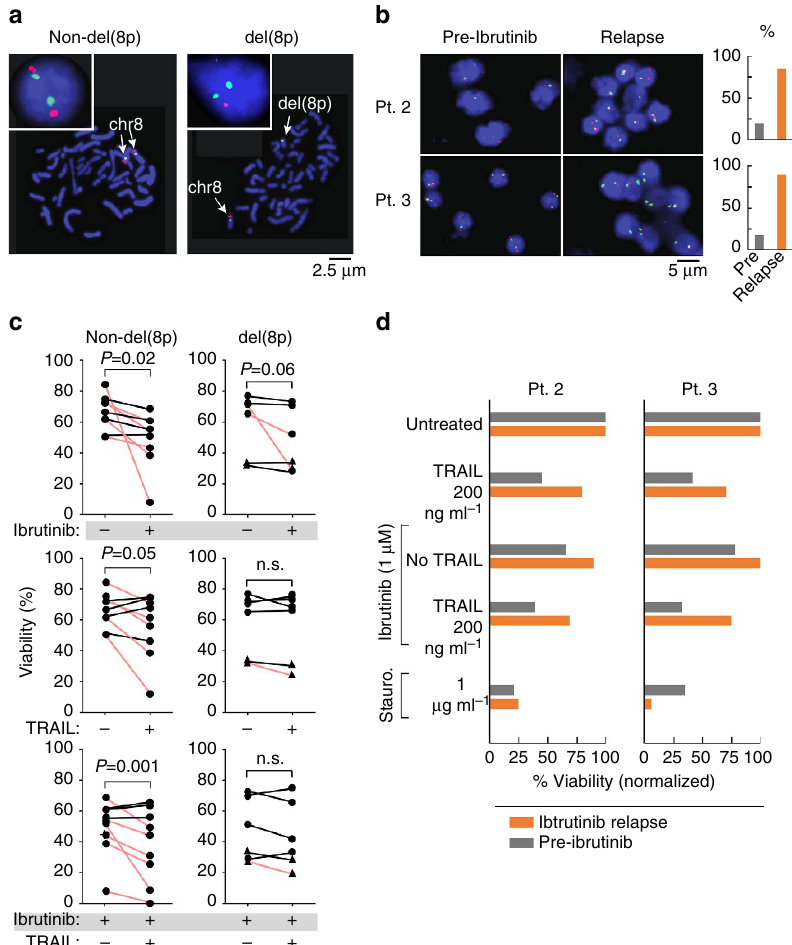
Figure 5 | Impact of del(8p) on apoptosis in response to ibrutinib and/or TRAIL in CLL. ( a ) Representative interphase and metaphase FISH results following hybridization for probes specific for chromosome 8p21.3 (red) and chromosome 8 centromere (green), showing a CLL cell with a normal disomic hybridization pattern or with deletion of chromosome 8p (details of the FISH probe in Supplementary Fig. 5a,b,d). ( b ) FISH hybridization of